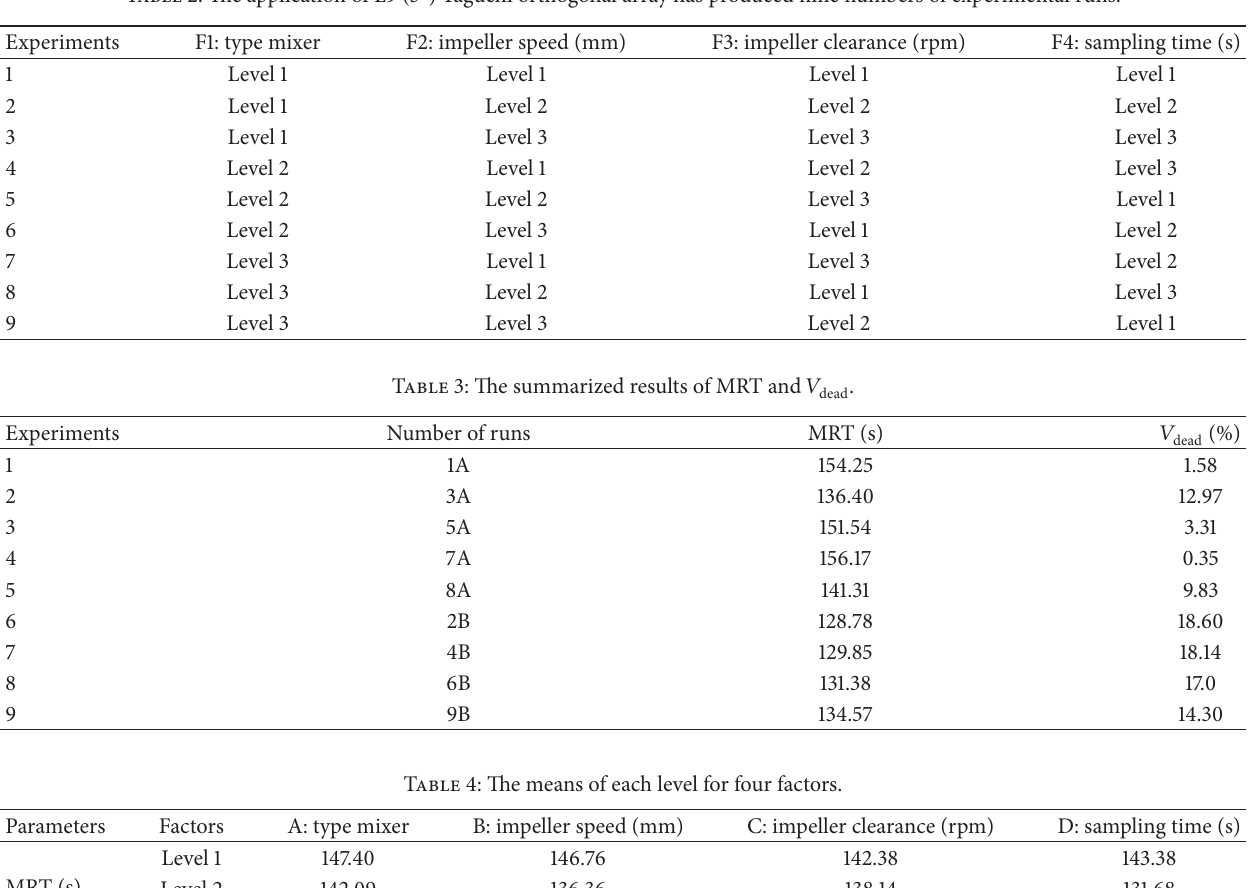
Table 2: The application of L9 (3 4 ) Taguchi orthogonal array has produced nine numbers of experimental runs.